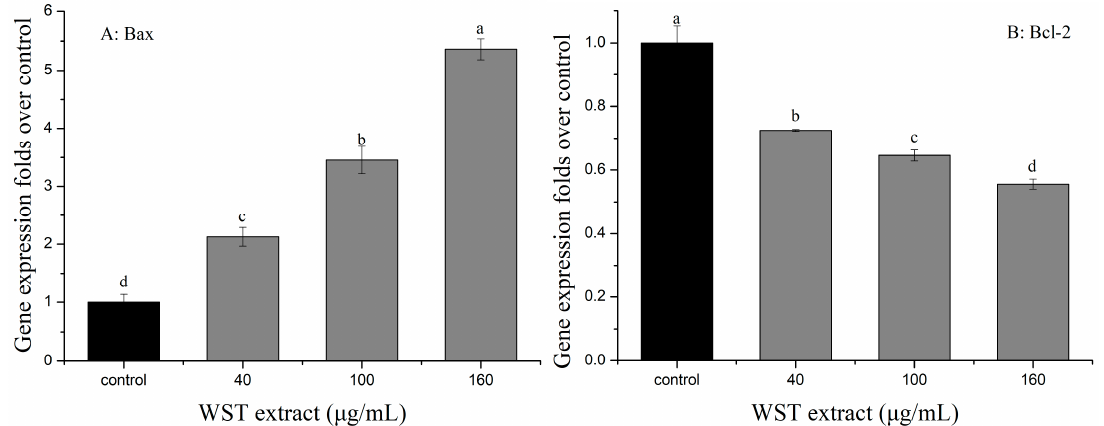
Figure 5. Effects of WST extracts on the gene expression of Bax ( A ) and Bcl-2 ( B ) in human hepatoma HepG2 cells. Fold ratio of Bax ( A ) and Bcl-2 ( B ) mRNA expression over the control. The calculation formula is as follows: gene expression/GAPDH × control numerical value (control fold ratio: 1). a-d Mean values with different letters in the same bar graph are significantly different ( p < 0.05) according to Duncan’s multiple range test. Appl. Sci. 2019 , 9 , x FOR PEER REVIEW